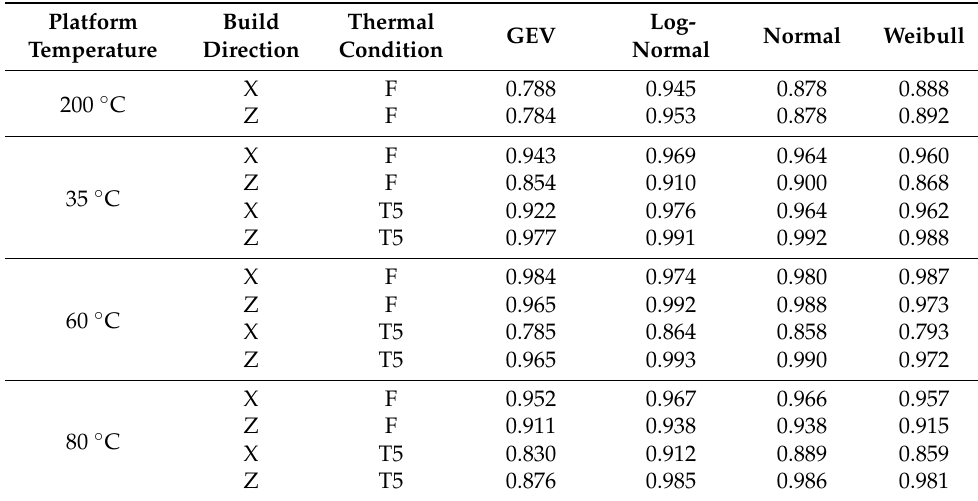
Table A2. Comparison of the distributions in terms of the coefficient of determination.